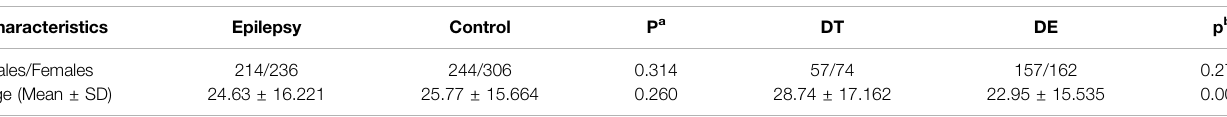
TABLE 1 | Demographic characteristics of the patients and